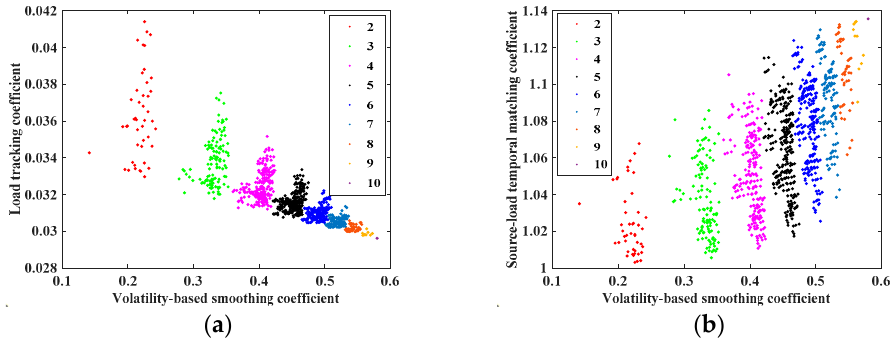
Figure 5. The source-load timing matching degree under different wind farm combinations. ( a ) The load tracking coefficient; ( b ) The source-load timing matching coefficient.